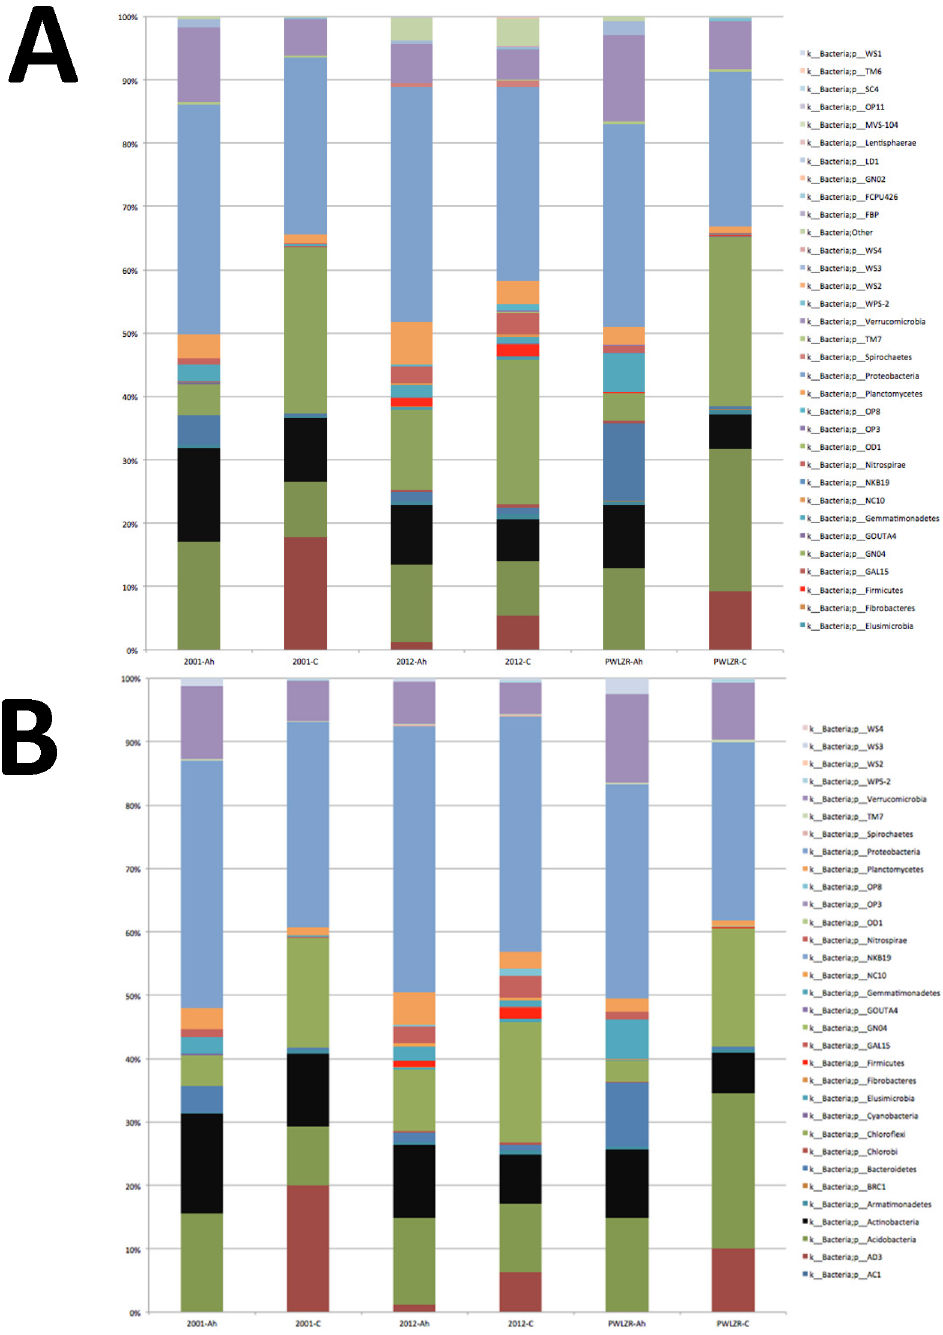
Figure 6. 16S V1–V3 Taxonomic Summary. Phylum-level taxonomic composition of ( A ) de novo and ( B ) closed-reference picked OTUs rarefied at 1499 and 1404 sequences per sample, respectively. For ( A ), taxonomy was assigned to the de-noised 454 pyrotag sequencing data using the RDP Classifier [53] using a confidence threshold of 80%. Each lane is the result of summarizing the experimental replicates by extraction method (N=2 libraries for the 2001 method and ORNL 2012 method A-horizon samples; N=3 libraries for the remainder of the sample/method combinations). For ( B ) if a given sequence did not match within 3% of any sequence within the Greengenes database [34,35], the sequence was discarded from the taxonomic summary. Taxonomy was assigned to the de-noised 454 pyrotag sequencing data using the RDP Classifier [53] via QIIME using a confidence threshold of 80%. Each lane is the result of summarizing the experimental replicates by extraction method. C=clay, Ah=A Horizon; PWLZR represents the samples extracted using the PowerLyzer System (MoBio). doi:10.1371/journal.pone.0102826.g006 development. A clay sample was taken at 20 cm below the surface consisted largely of gravel, sand, coal fragments, and iron cemented clay. To prevent loss of precious sediment, alternative of deciduous forest A-horizon in Knoxville, TN and maintained at samples containing iron cemented clay were used for method 21 u C for . 3 days. The top 5.1 cm of A-horizon soil were used to